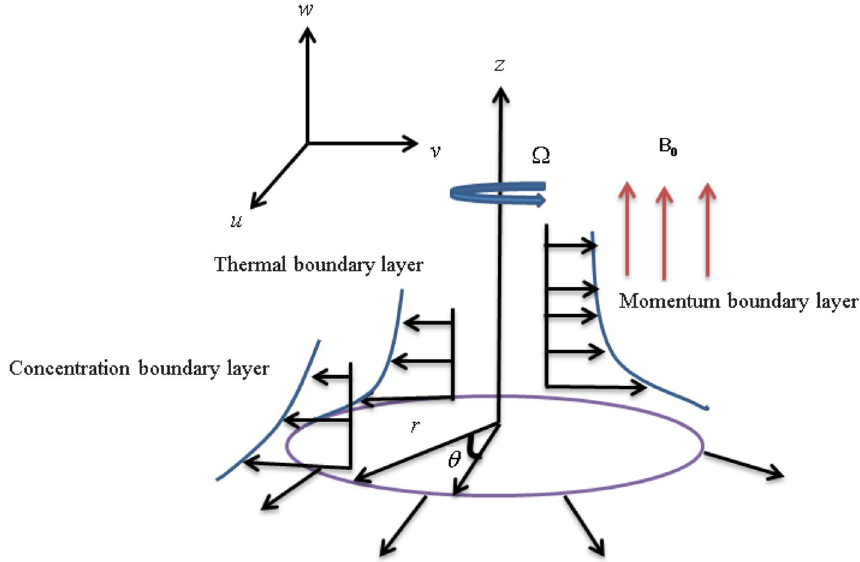
Figure 1. Sketch of the coordinates